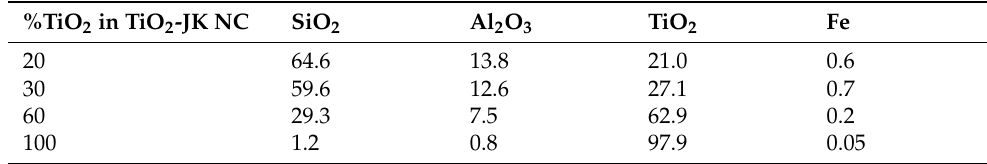
Table 1. XRF data of the various TiO 2 -JK composites (as mass%).